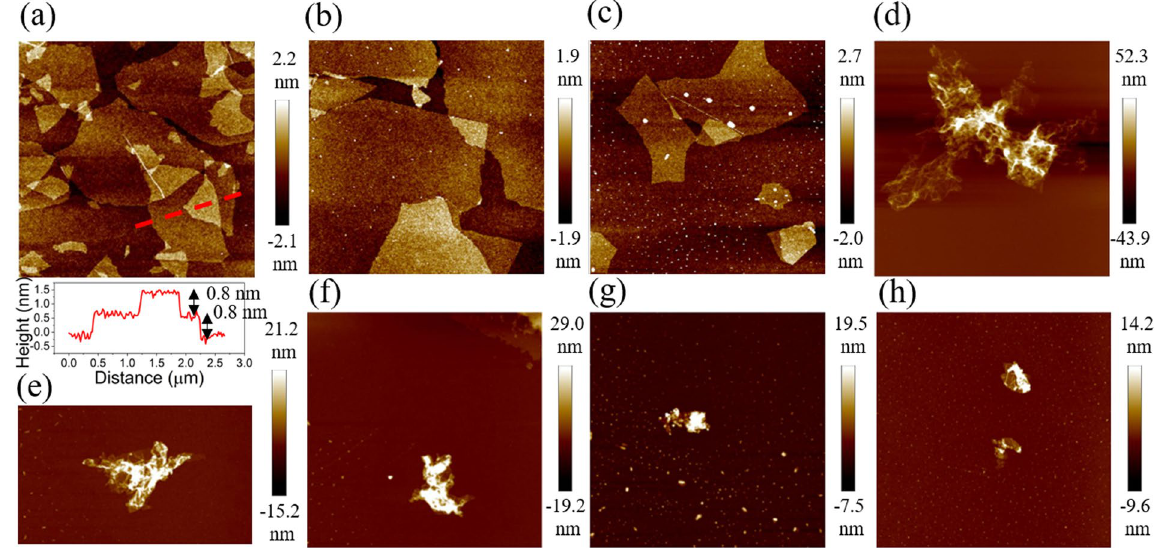
Figure 3. AFM images of the rGO samples treated at ( a ) GO, rGO ( b ) 30 min, ( c ) 1 h, ( d ) 2 h, ( e ) 4 h, ( f ) 6 h, ( g ) 8 h, ( h ) 10